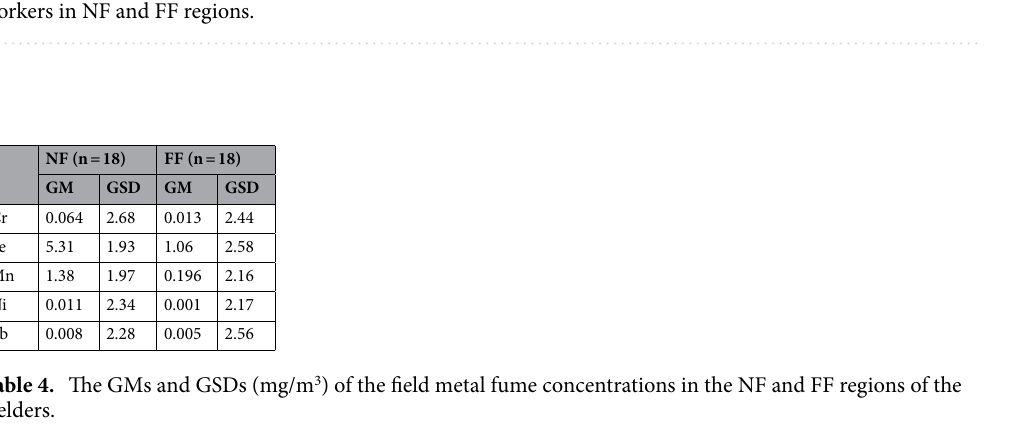
Table 3. The GMs and GSDs (mg/m 3 ) of the predicted long-term exposure concentrations of shipyard workers in NF and FF regions.